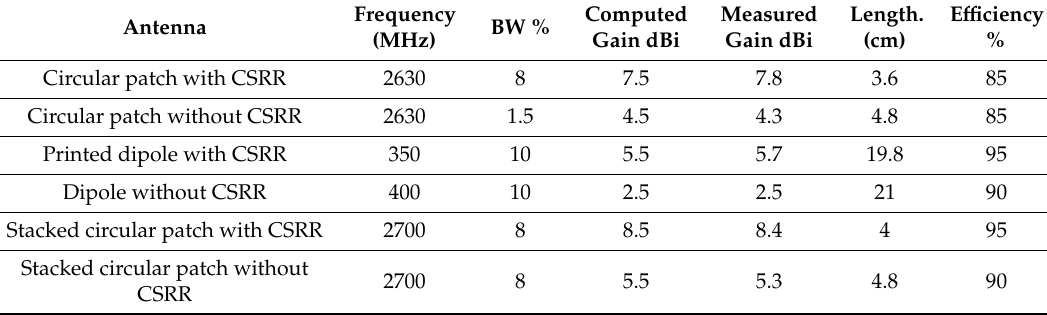
Table 6. Comparison between printed antennas with and without CSRR.